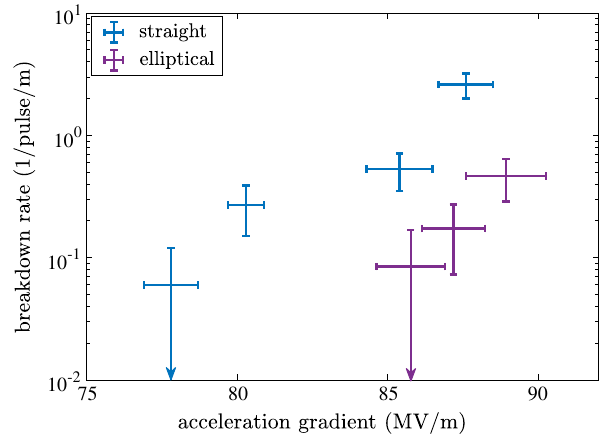
FIG. 16. Breakdown rate measurement results of the accelerator structures with an axisymmetric elliptical (E) and straight (S) central cell sidewall